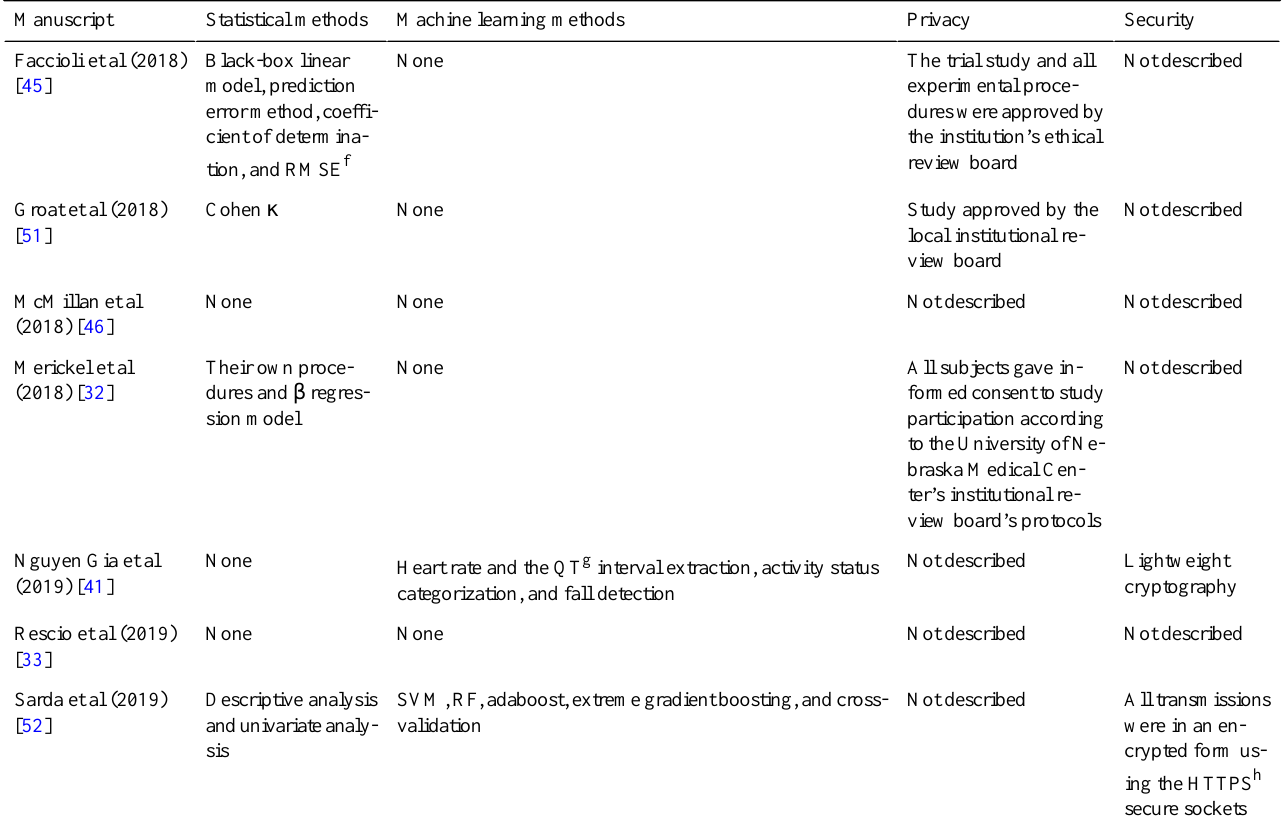
algorithm for different sensor signal